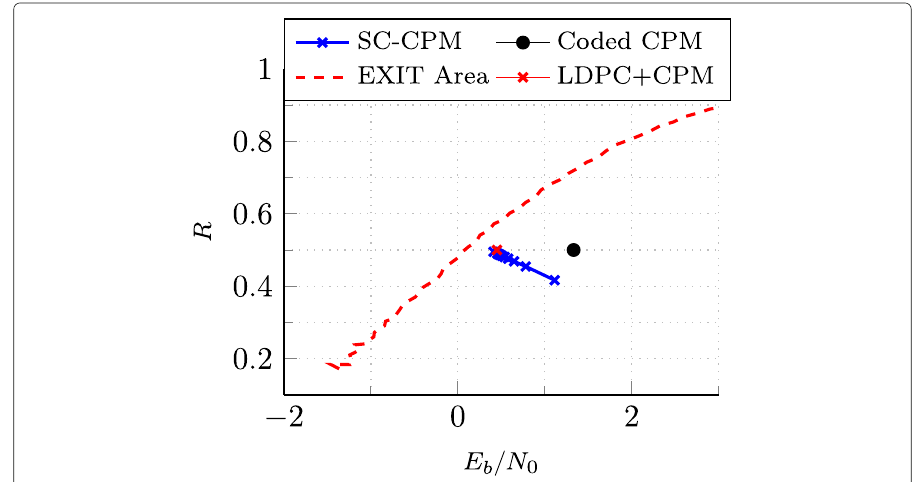
Fig. 10 Quaternary CPM used in DVB-RCS2 with h = 1 / 5, L c = 2, α = 1 / 3 and natural mapping. The coupling matrix is always given by B = [ 1